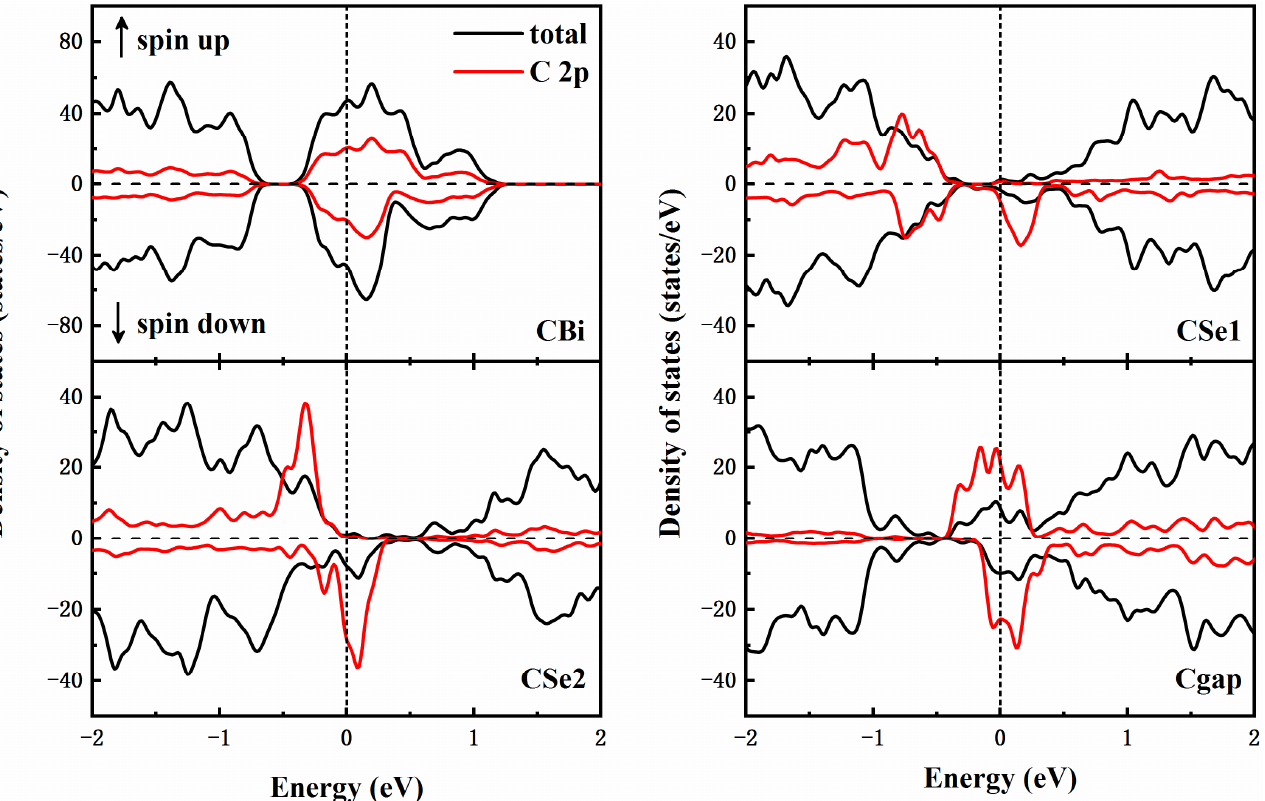
Figure 4. The total DOS and PDOS of C doping Bi 2 Se 3 .